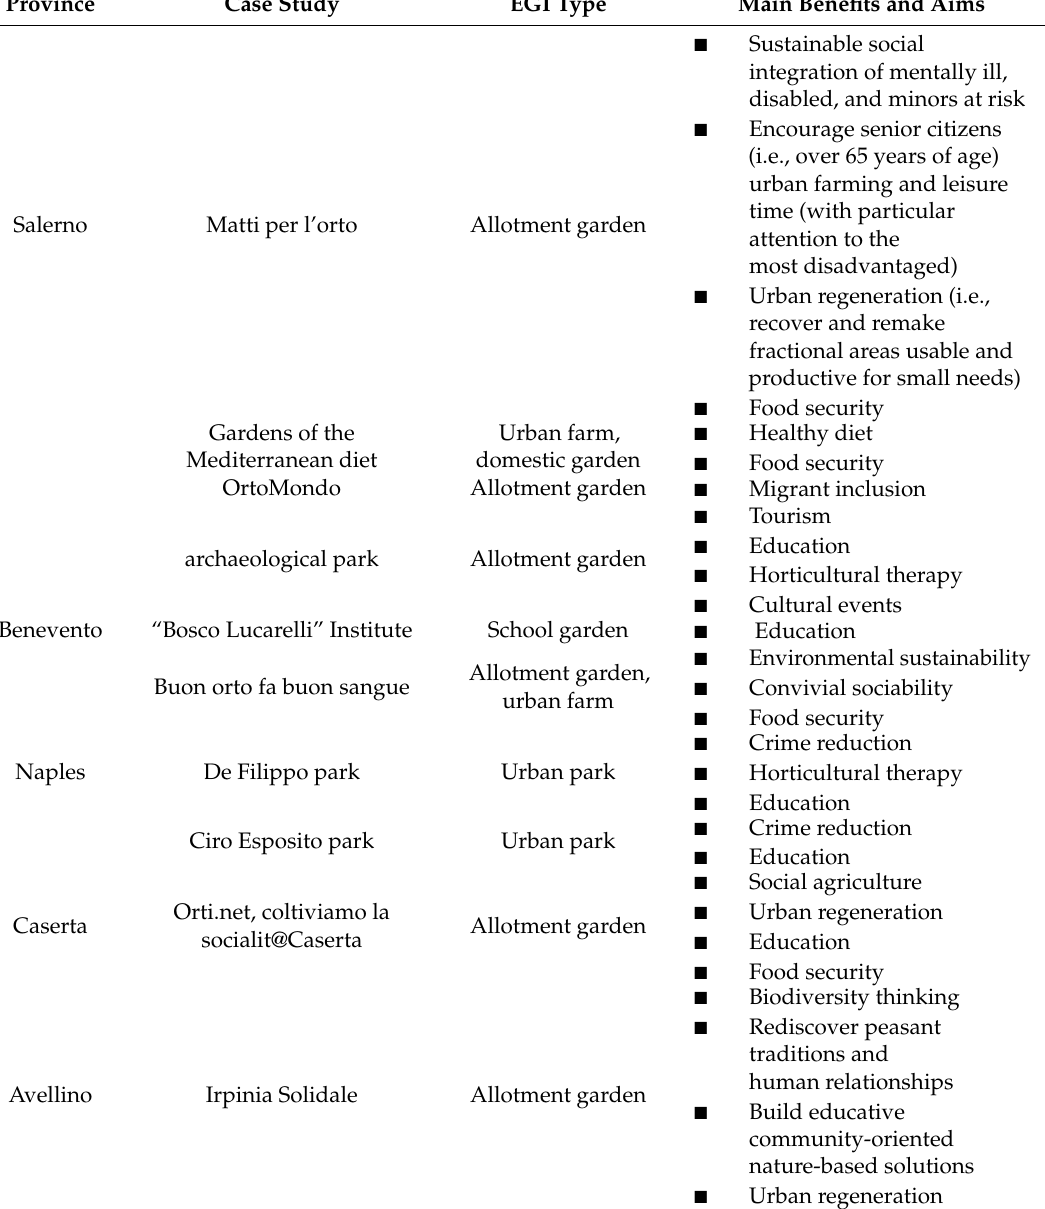
Table 2. EGI case studies in the Campania